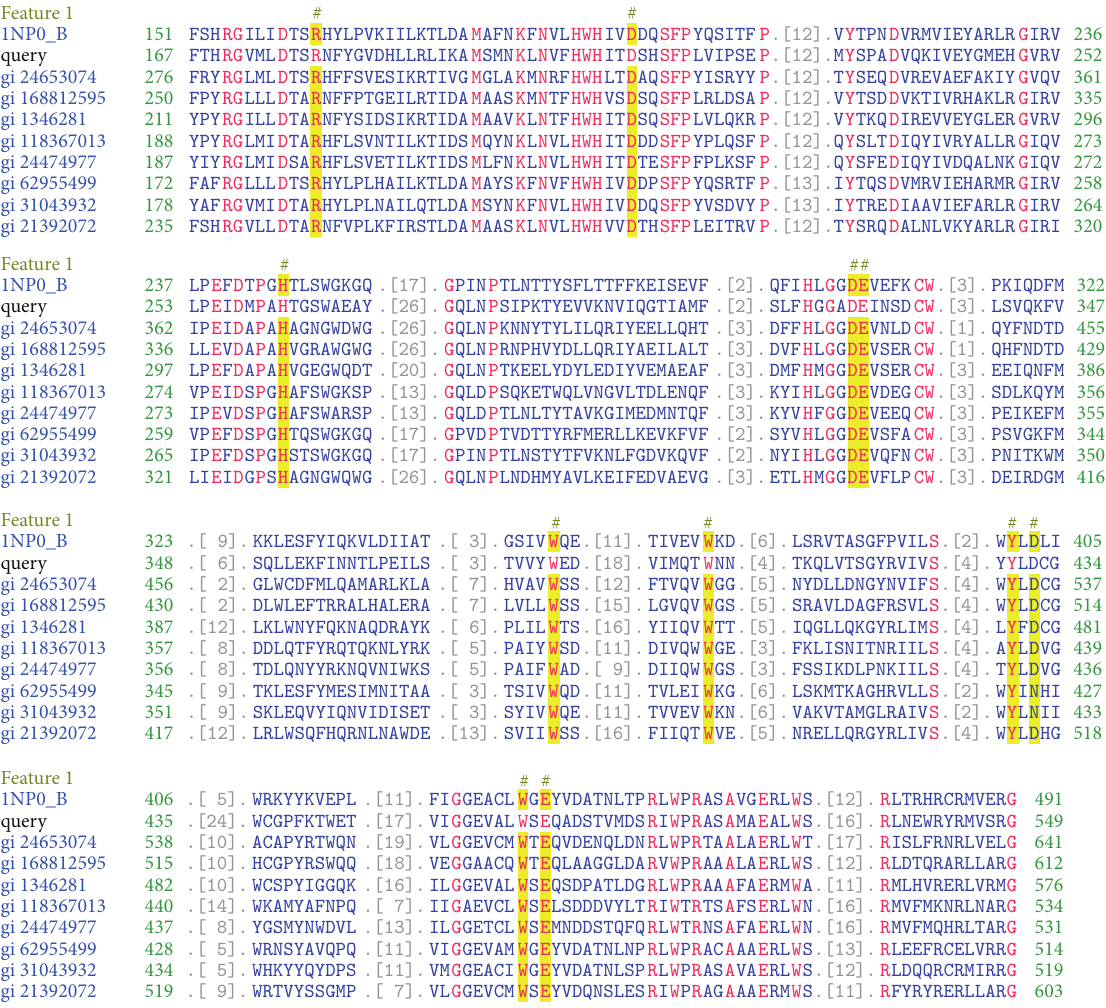
Figure 2: Sequence alignment of 𝛽 -Hex-Sl with nine other sequences by CD search. The amino acid residues Arg(178), Asp(207), His(261), Asp(330), Glu(331), Trp(378), Trp(404), Tyr(430), Asp(432), Trp(494), and Glu(496) were predicted to be responsible for the activity of 𝛽 - Hex-S. The conserved amino acids are shown as yellow